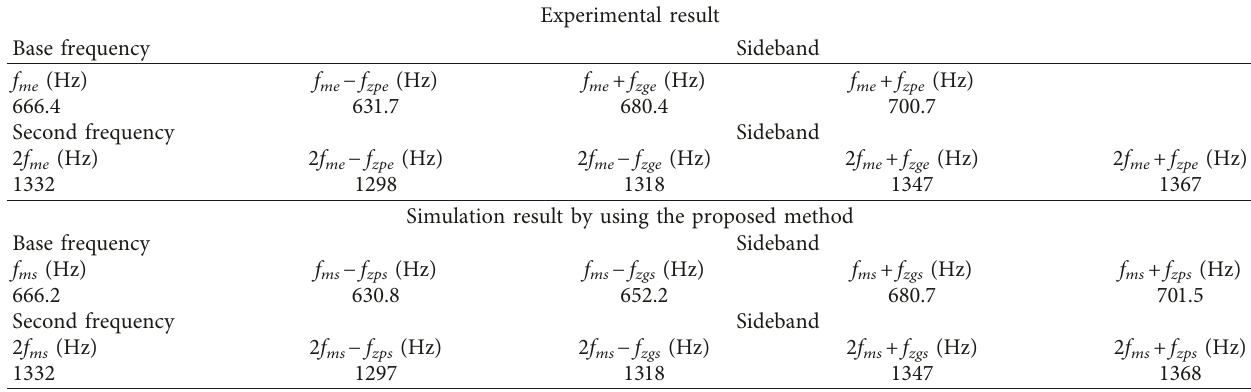
Table 7: Sidebands in experimental and simulation results at